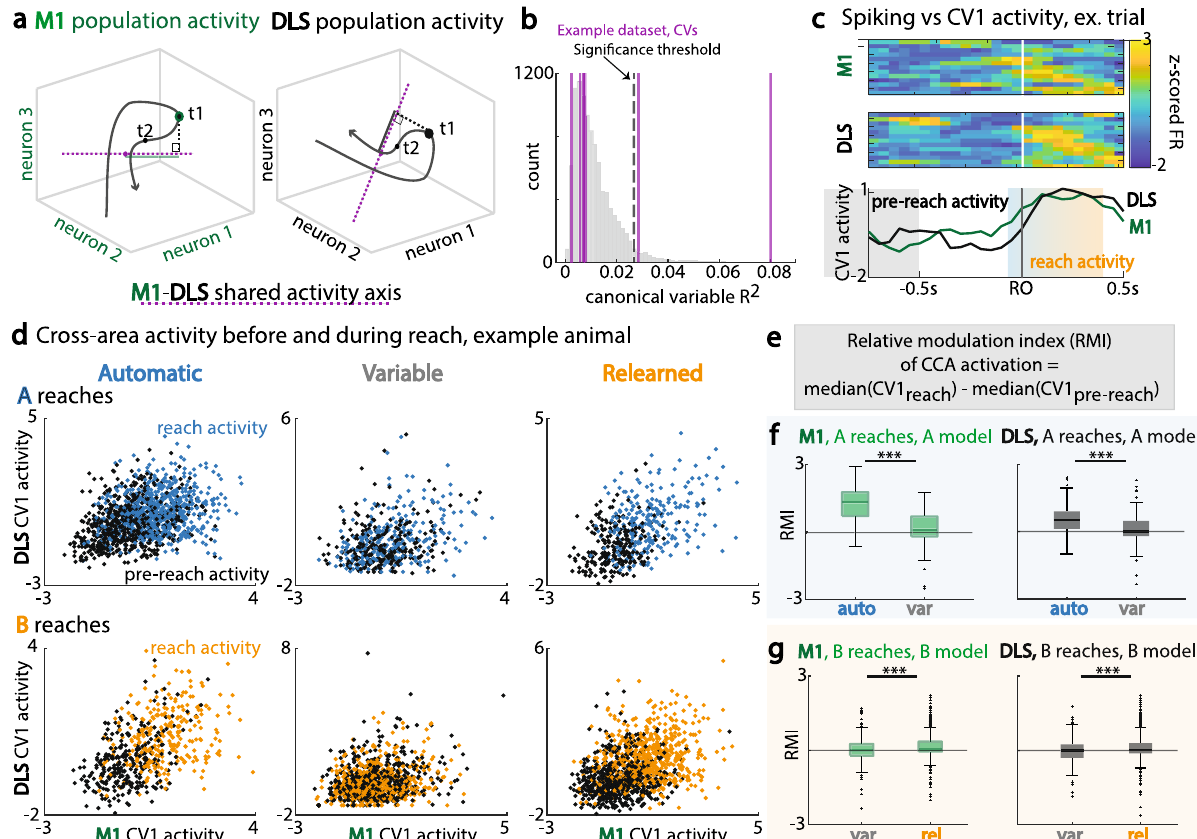
Fig. 5 Changes in M1-DLS cross-area subspace modulation. a Canonical correlation analysis (CCA): identi fi cation of axis with maximal correlation between M1 and DLS activity (purple dotted line), with example value of projected population activity at time t1 (solid line on shared axis) for M1 population activity (left, green) and DLS population activity (right, black). b Example bootstrap shuf fl ed distribution of R 2 values for identi fi cation of signi fi cant canonical variable (CV) axes. c Top: single-trial M1 spiking activity. Middle: single-trial DLS spiking activity. Bottom: corresponding single-trial M1 (green) and DLS (black) activations along CV1. Pre-reach period (gray) is − 1 to − 0.5 s before fi rst reach onset. Reach period (blue-orange) is − 0.1 s to 0.4 s around fi rst reach onset. d M1 and DLS cross-area activity before (black) and during (color) reach, for A trials (top row) and B trials (bottom row) across session types for example animal. e Equation for relative modulation index (RMI) of CCA activation, comparing reach and pre-reach periods. f RMI for trials with fi rst reach to A, for M1 activations (left, green) and DLS activations (right, green), across automatic and variable sessions. R1 to A, M1 and DLS RMI: auto, n = 220 trials; var, n = 95 trials. Data are presented as box plots with 25th, 50th, and 75th percentiles. g Same as ( f ), for trials with fi rst reach to B, across variable and relearned sessions. R1 to B, M1 and DLS RMI: var, n = 150 trials; rel, n = 464 trials. Data are presented as box plots with